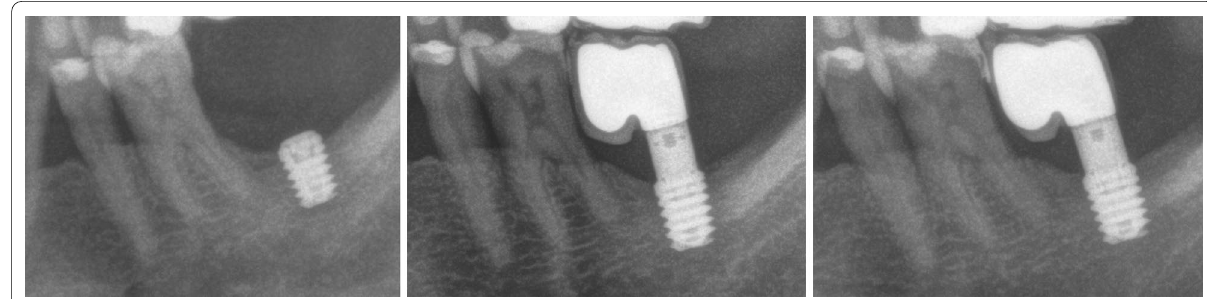
Fig. 1 Left : 6.5 length implant placed in #3.7 position. Center: 2 years later; single screw-retained crown over 4 mm. straight transepithelial (intermediate abutment). Right: 6 years after implant placement. No marginal bone loss observed after 6-year follow-up